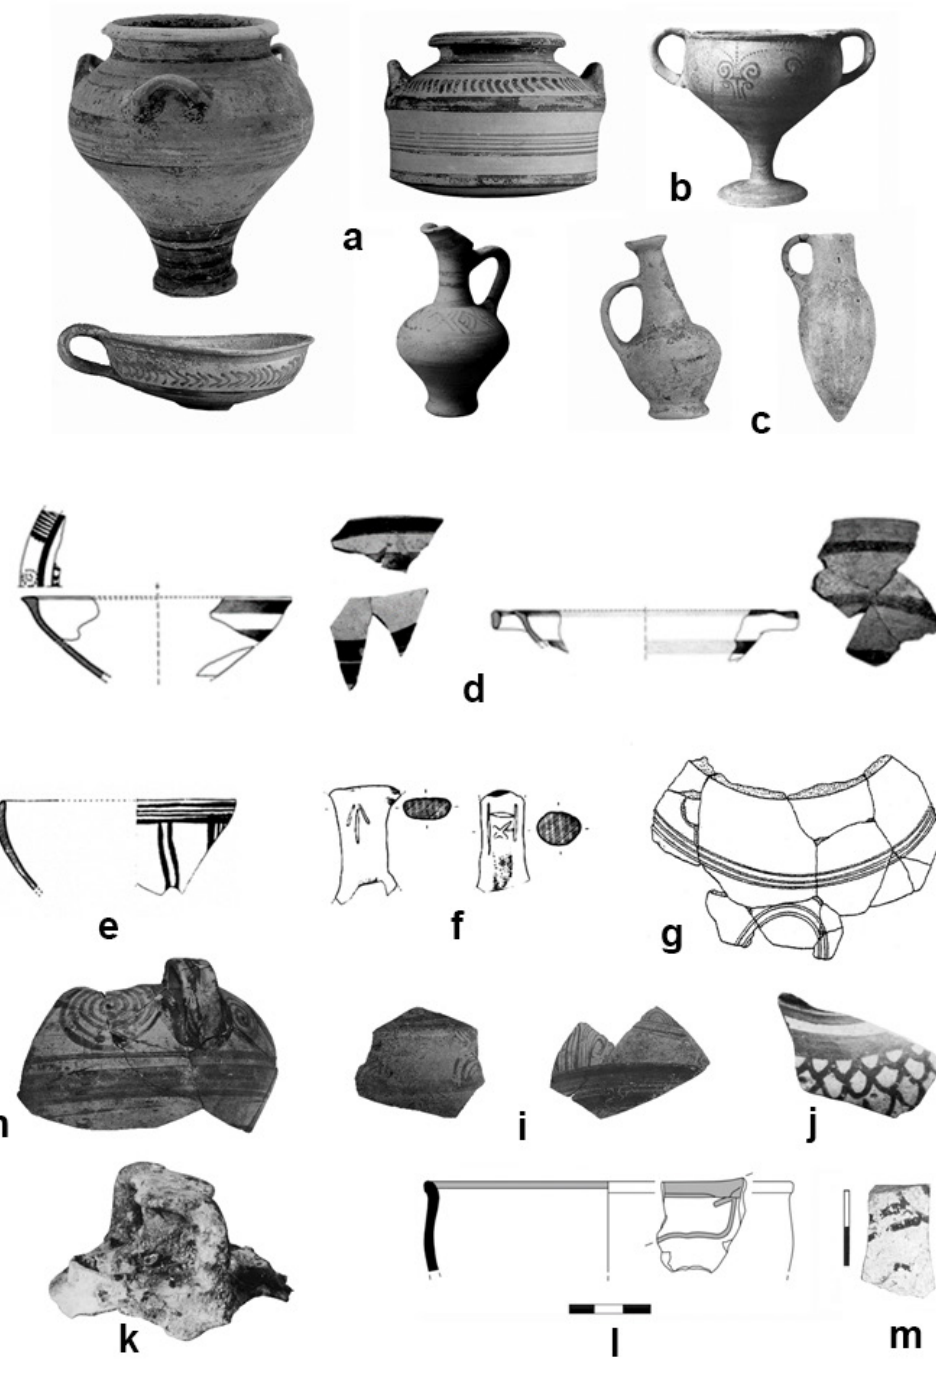
Figure 3: a) Late Helladic IIIA–B pottery from Thapsos (Tanasi, 2009); b) Late Helladic IIIA2 kylix from tomb. 7 of Cozzo del Pantano (Tanasi & Trapani, 2019); c) Base Ring juglet and White Shaved juglet of Cypriote type from tomb D. of Thapsos (Tanasi, 2009); d) Levanto-Mycenaenan bowls from Cannatello (Graziadio & Gugliemino, 2011); e) White Slip II ware from Cannatello (Alberti, 2008); f) Handles displaying incised Cypro-Minoan signs from Cannatello (Day & Joyner, 2005); g) Pithos ware from Cannatello (Alberti, 2008); h) Late Helladic III A–B pottery from Hut no. 16 Punta Milazzese settlement at Panarea (after Bernabò Brea & Cavalier, 1968); i) Late Helladic IIIB–C pottery from Lipari (Bernabò Brea & Cavalier, 1980); j) Late Helladic IIIA–B pottery from Hut no. 6 of Capo Graziano settlement at Filicudi (after Bernabò Brea & Cavalier, 1991); k) Late Helladic IIIA–B stirrup jar from offshore Filicudi (after Bernabò Brea & Cavalier, 1991); l) Late Helladic III B kylix from Borġ in-Nadur temple (Tanasi, 2018); m) Late Helladic IIIB body sherd from Tas-Silg south (Tanasi,